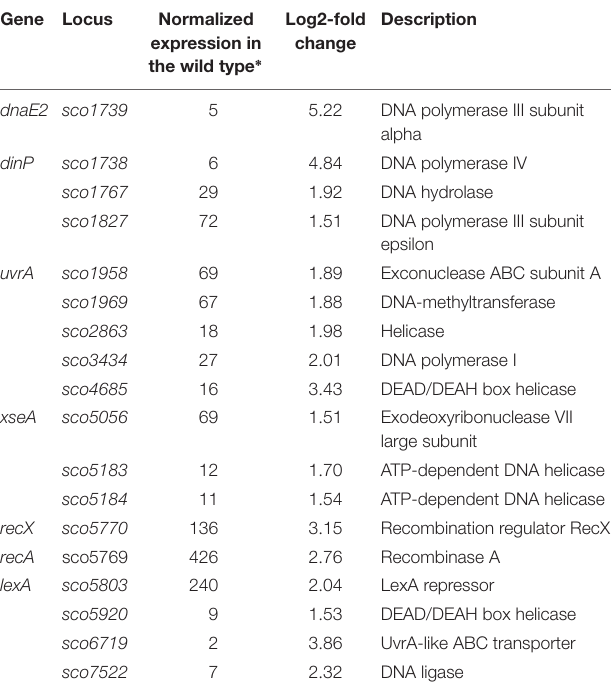
TABLE 5 | DNA processing and DNA repair genes impacted by constitutive topA -downregulation (based on RNA-Seq data; log2-fold > 1.5; p < 0.05). Gene Locus Normalized expression in the wild type ∗